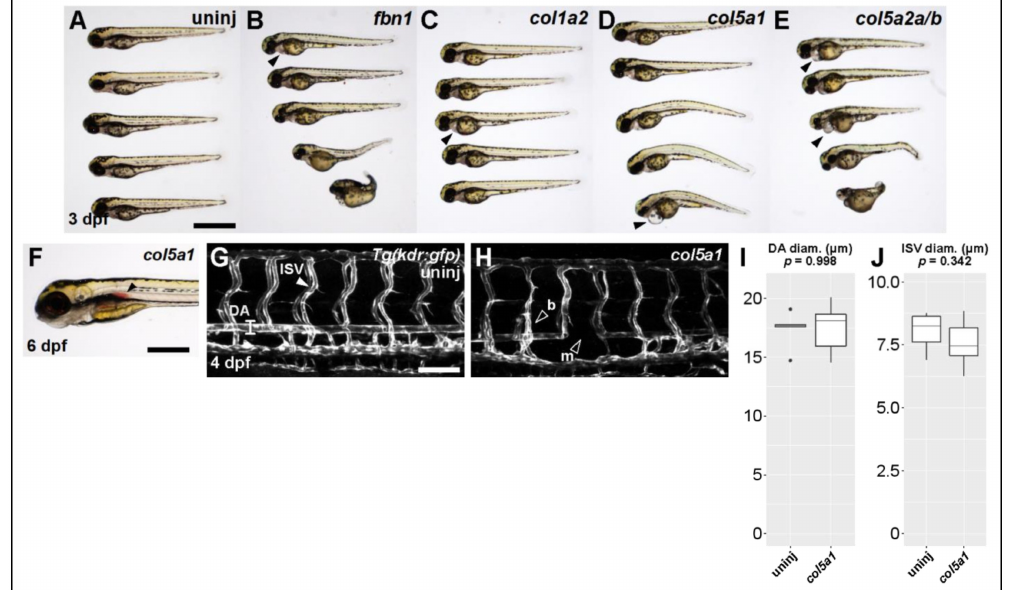
Figure 3. Knocking out Ehlers-Danlos and Marfan Syndrome-related genes generates vascular phenotypes. ( A ) Brightfield macroscopic image of representative series of uninjected larvae at 3 dpf. Scale bar: 1 mm. ( B ) Similar image of fbn1 knockout fish. Filled arrowhead indicates cardiomegaly. ( C ) Similar image of col1a2 knockout fish. ( D ) Similar image of col5a1 knockout fish. ( E ) Similar image of col5a2a/b knockout fish. ( F ) Closeup brightfield image of a 6 dpf col5a1 knockout fish with visible aortic hemorrhage (filled arrowhead, scale bar: 500 µ m). ( G ) Confocal micrograph of trunk vasculature of a 4 dpf uninjected Tg(kdr:gfp) fish. DA: dorsal aorta, ISV: intersegmental vessel. Scale bar: 100 µ m. ( H ) Similar micrograph of a col5a1 knockout fish. Empty arrowheads indicate b: excessively branching segment and m: missing segments. ( I ) Quantification of DA diameter. Diameter is not significantly changed across conditions ( t -test, p = 0.998). ( J ) Quantification of ISV diameter. Diameter is not significantly changed across conditions ( t -test, p =